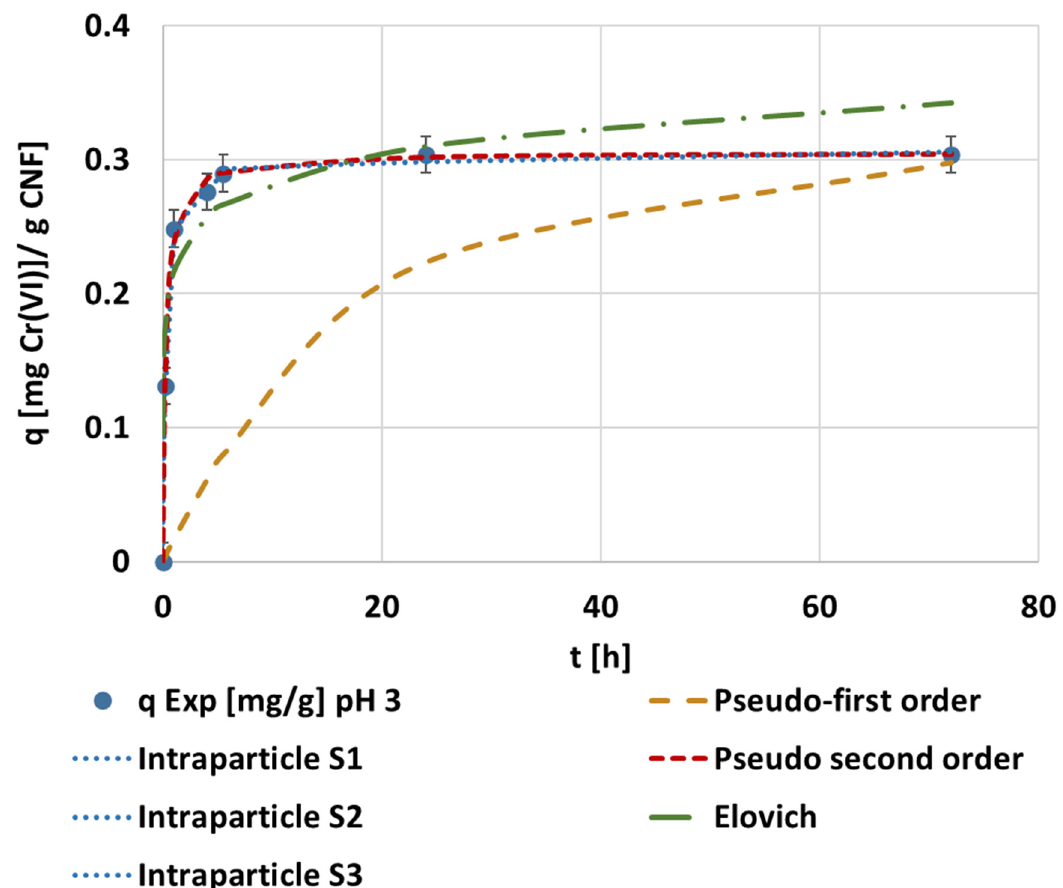
Figure 5. The evolution of the kinetic adsorption experiment at 0.1 mg·L − 1 of the initial chromium concentration, 1.5 mmol MTMS·g − 1 CNF applied during hydrophobization and 1000 mg CNF·L − 1 of dosage under pH 3 conditions and the kinetic fitting of the pseudo-first, pseudo-second, Elovich, and intraparticle models.